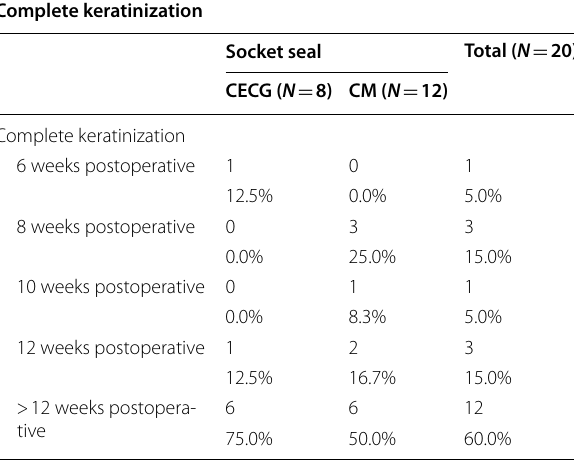
Table 3 Complete keratinization per Socket Seal type over time illustrated by absolute and relative